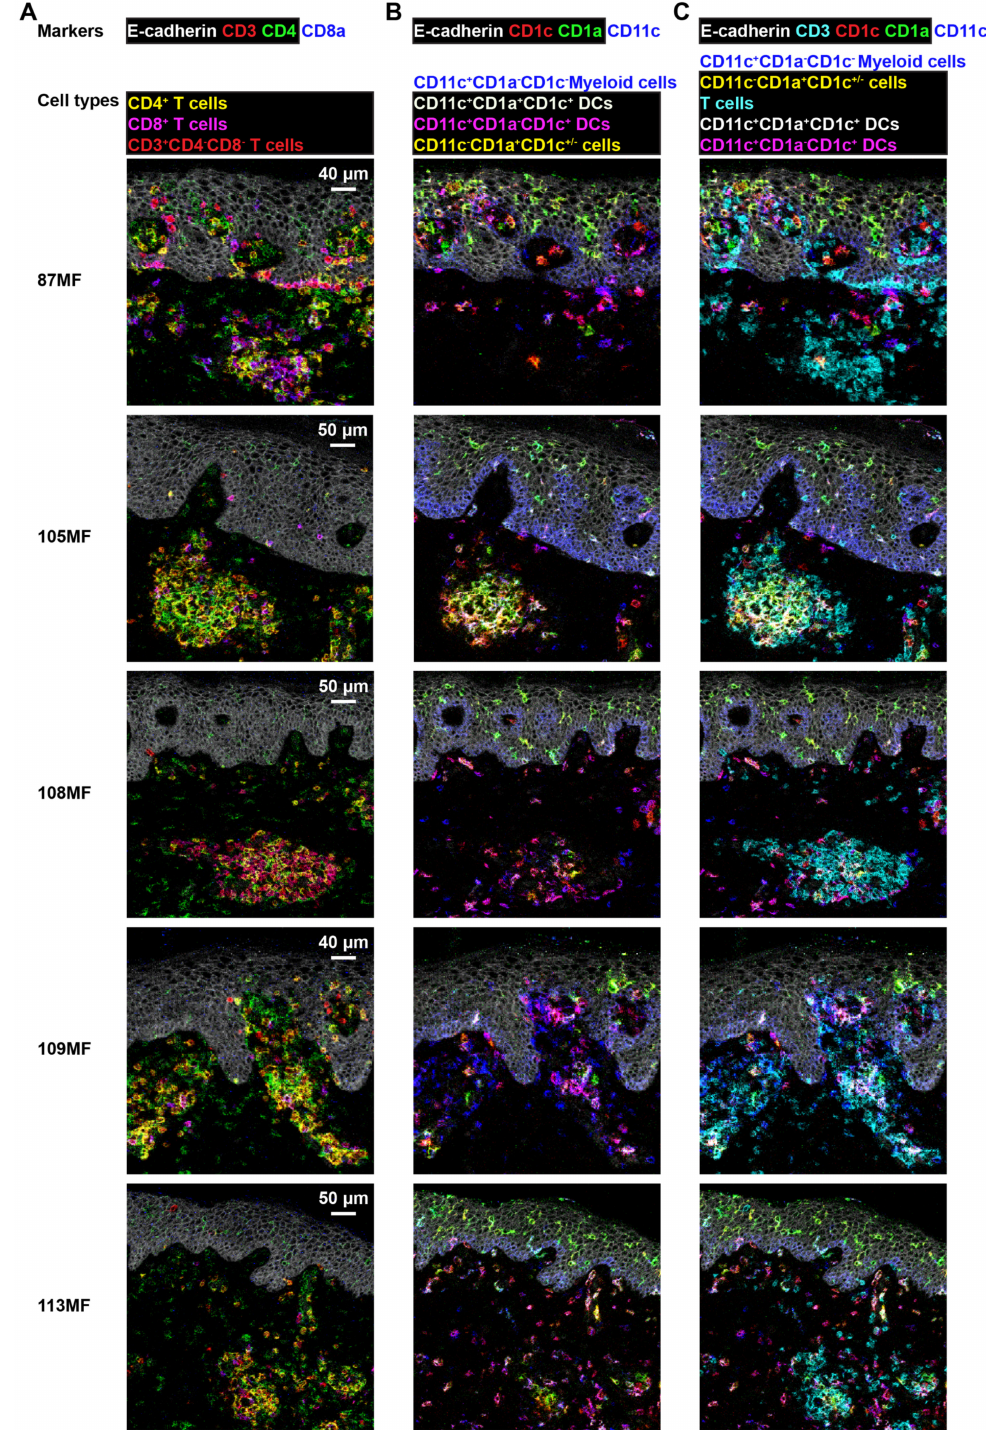
Figure 6. Detection of cell–cell interaction by combining T-cell markers with myeloid cell markers in skin biopsies of five additional MF patients: ( A ) visualization of CD4 + T cells, CD8 + T cells, and CD4 − CD8 − T cells; ( B ) visualization of multiple types of antigen-presenting cells (APCs) by the overlay of CD1c (colored in red), CD1a (colored in green), and CD11c (colored in blue); ( C ) the overlay of CD3 (colored in cyan), CD1c (colored in red), CD1a (colored in green), and CD11c (colored in blue) shows the distribution of the myeloid and T-cell populations and the complex interactions among